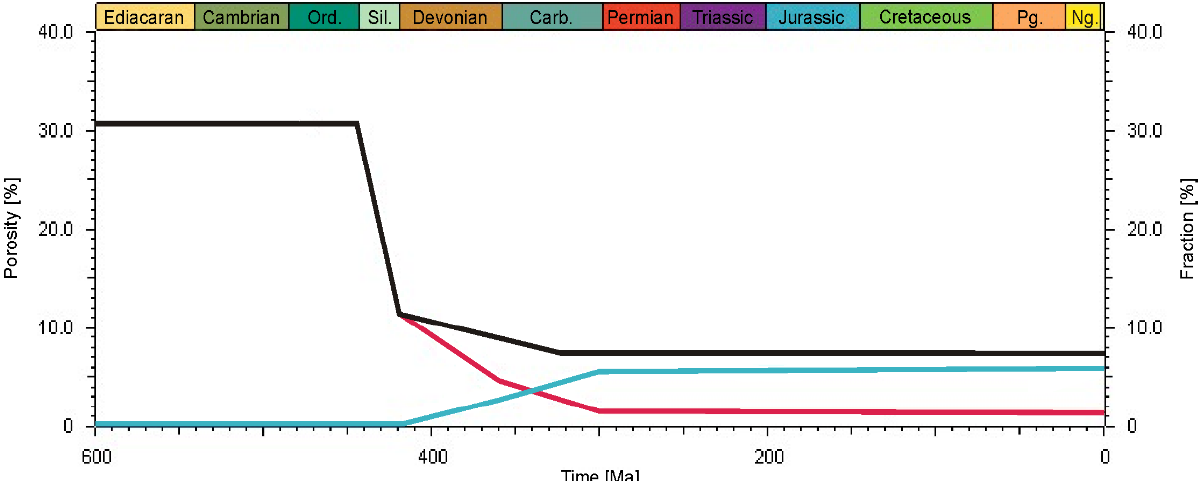
Figure 13. Evolution of diagenetic mechanical and chemical compactions of Ediacaran–Lower Cambrian sandstones. Explanations: red line—porosity changes in Lower Cambrian sandstones, in the vicinity of the S ł upsk IG-1 well; black line—porosity changes caused by mechanical compaction; blue line—porosity loss caused by chemical compaction.